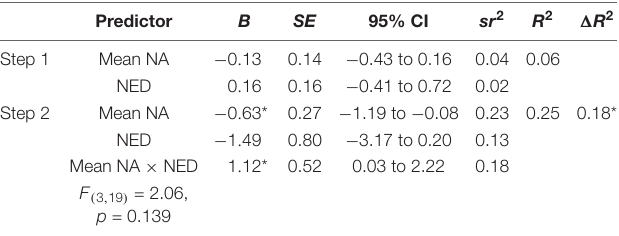
TABLE 2 | Significant Two-way (Mean NA by NED) interaction predicting medication adherence ( n =